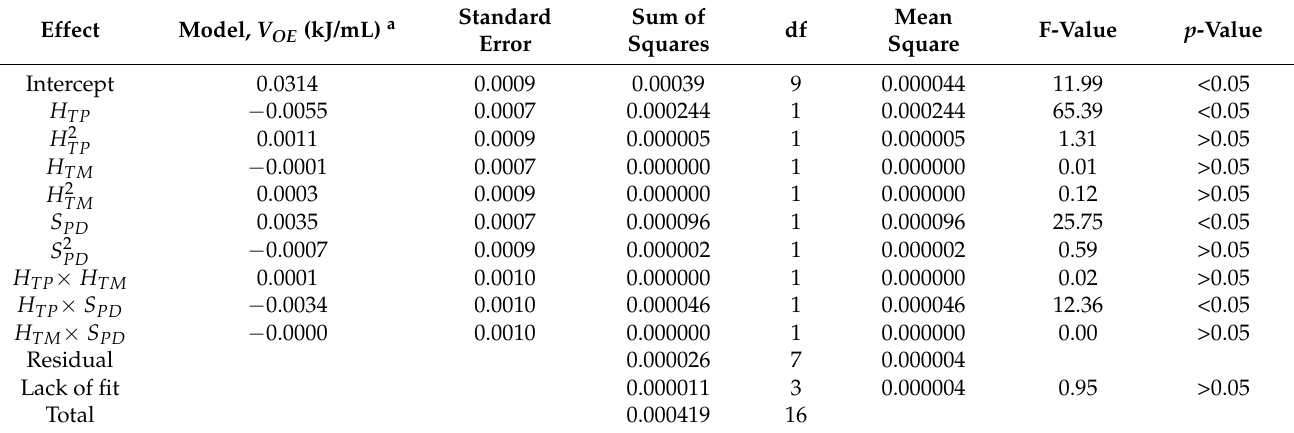
Table 7. Regression analysis of volume of oil energy, V OE (kJ/mL), under heating temperatures.